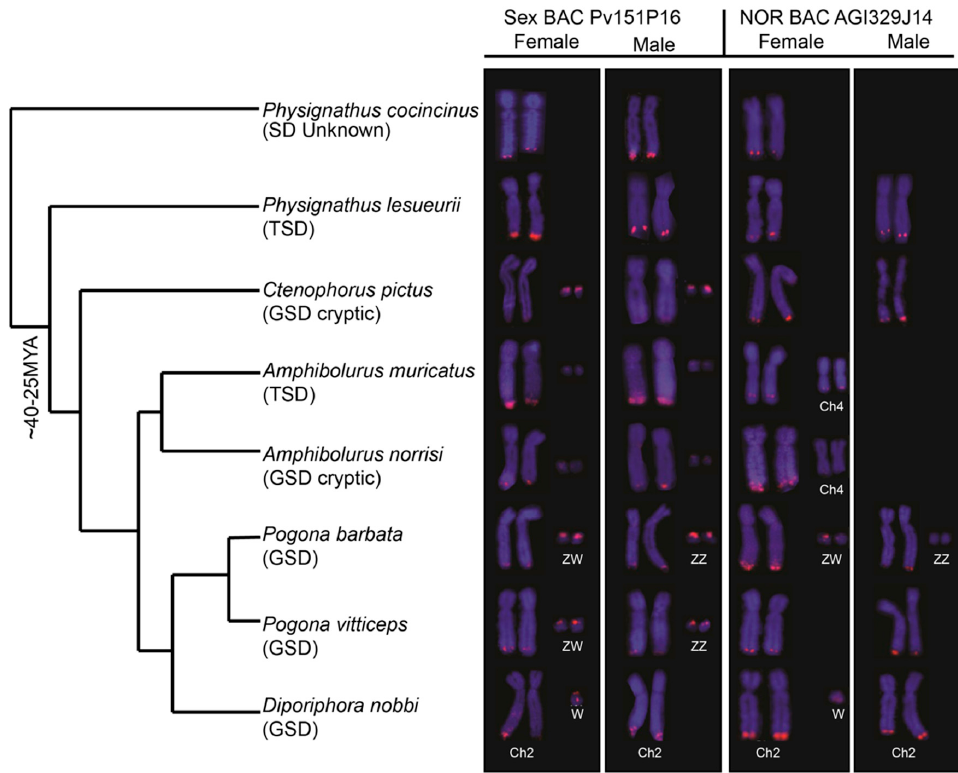
Figure 1. Physical mapping of Pogona vitticeps sex chromosome BAC (bacterial artificial chromosome) clone Pv151P16 (PviZW) and nucleolar organising region (NOR) (18S–28S rDNA) containing BAC clone AGI329J14 in eight species of dragon lizards showing locations and variable intensities of hybridisation signals on chromosome 2, ZW sex chromosomes, a pair of microchromosomes and a pair of chromosome 4. Both BAC clones were hybridised onto the telomeric region of chromosome pair 2 and ZW sex chromosomes in P. barbata . The PviZW BAC clone hybridised onto the telomeric region of chromosome pair 2 and the ZW sex chromosomes in P. vitticeps , while the NOR BAC clone hybridised onto the telomeric region of chromosome pair 2 only and not onto the ZW sex chromosomes or on any other chromosomes. This pattern of hybridisation was also observed in two other GSD species with cryptic sex chromosomes and one TSD species. We were unable to determine whether the microchromosome pair were sex chromosomes in those species. Similar patterns were also observed in D. nobbi , except that no hybridisation signal was observed on the Z chromosome for either probes. Hybridisation signal from the NOR BAC clone onto chromosome 4 was observed in A. muricatus and A. norrisi . The